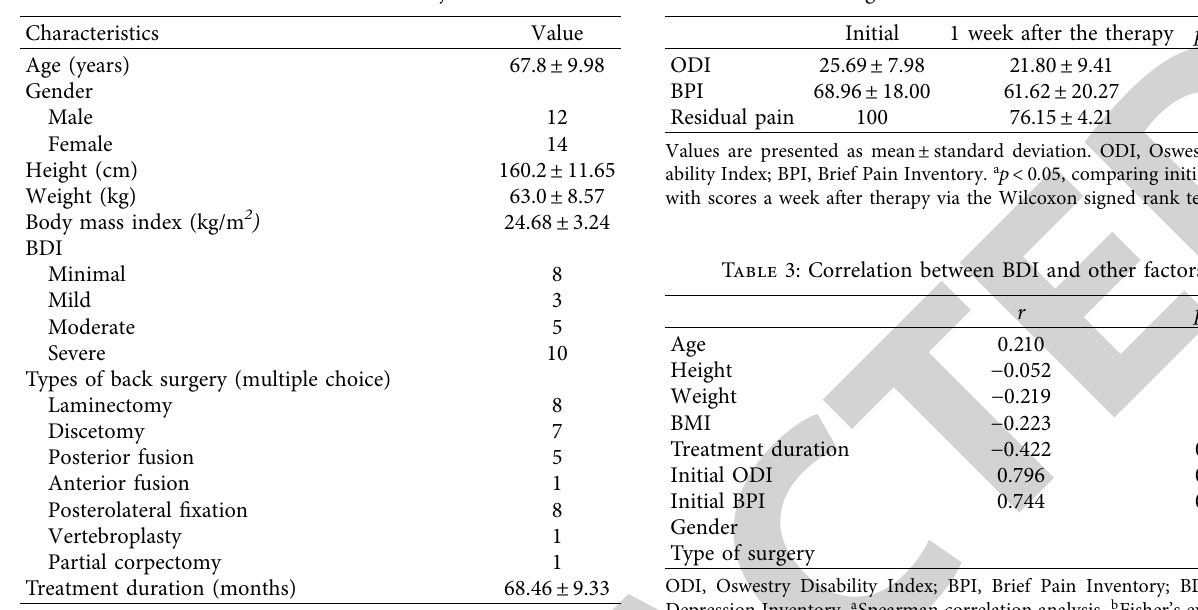
Table 1: Characteristics of subjects. Table 2: Changes in the total ODI and BPI scores.